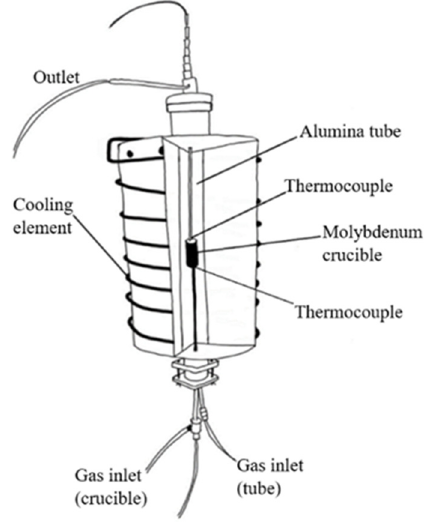
Figure 2. A schematic drawing of the reduction furnace.